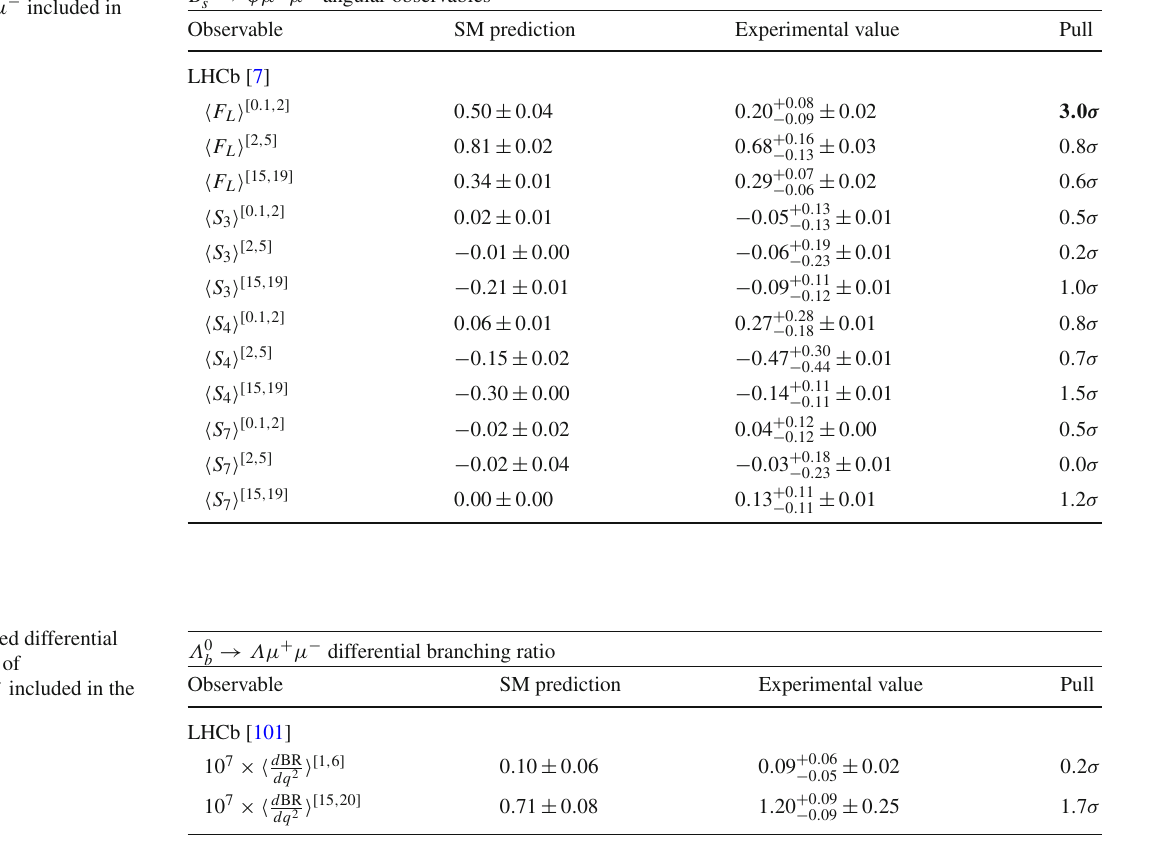
of B 0 s → φμ + μ − included in the global fit